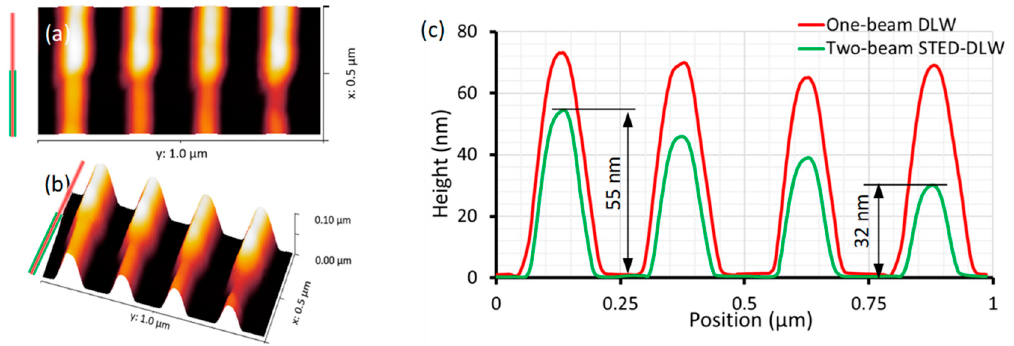
Figure 6. Atomic force microscope (AFM) images and height profile of the four nanowires, with 11 Figure 6. ( a , b ) Atomic force microscope (AFM) images of fabricated nanowires ( c ) height profile of the mW two-photon excitation power and depletion power from left to right 10, 15, 20, and 25 mW four nanowires, with 11 mW two-photon excitation power and depletion power from left to right 10, respectively. 15, 20, and 25 mW respectively.